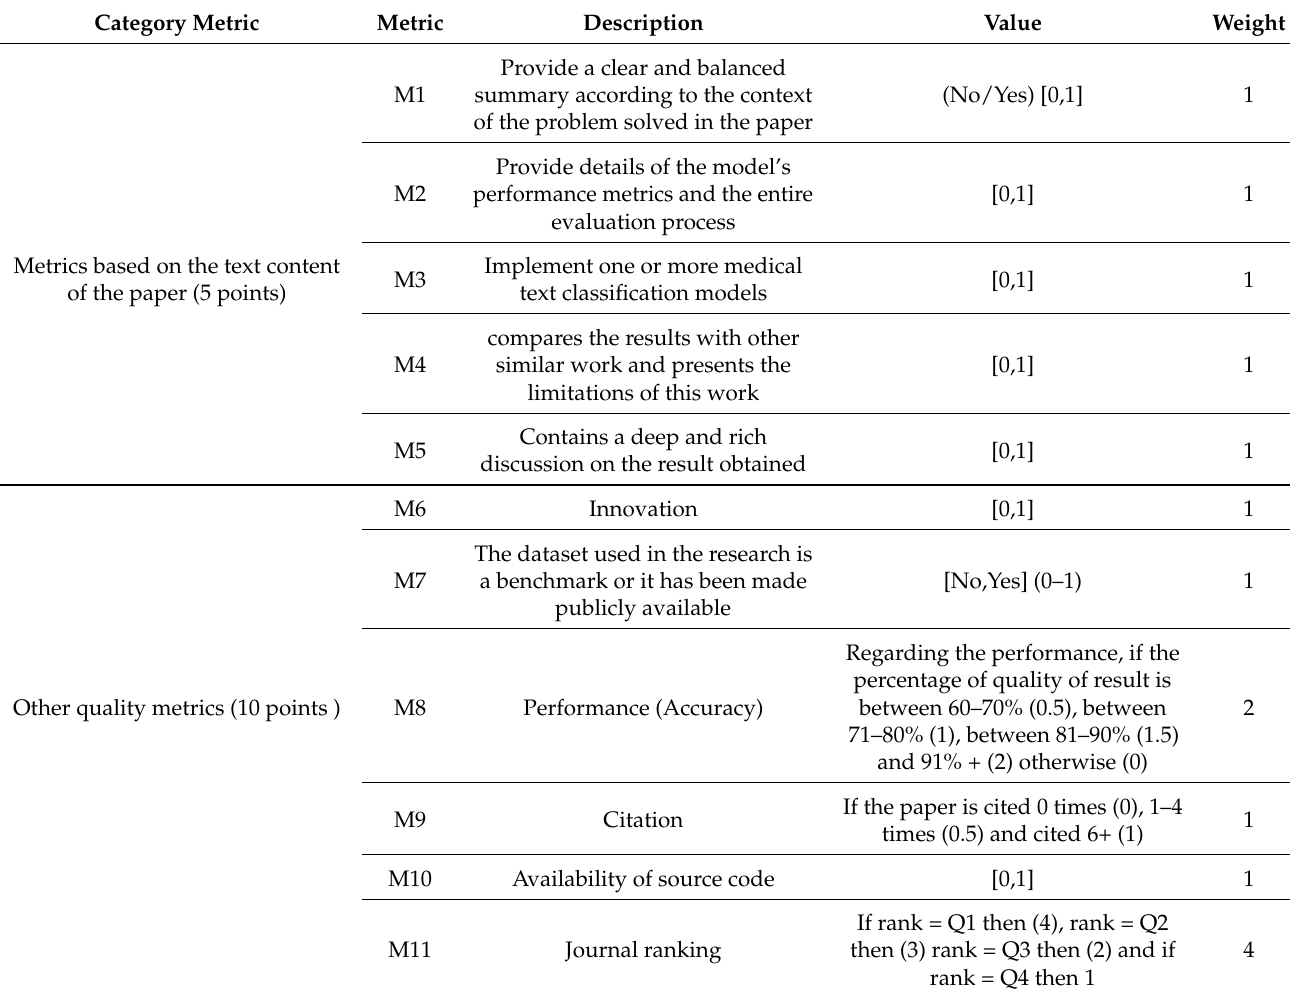
Table 3. Quality metrics of paper